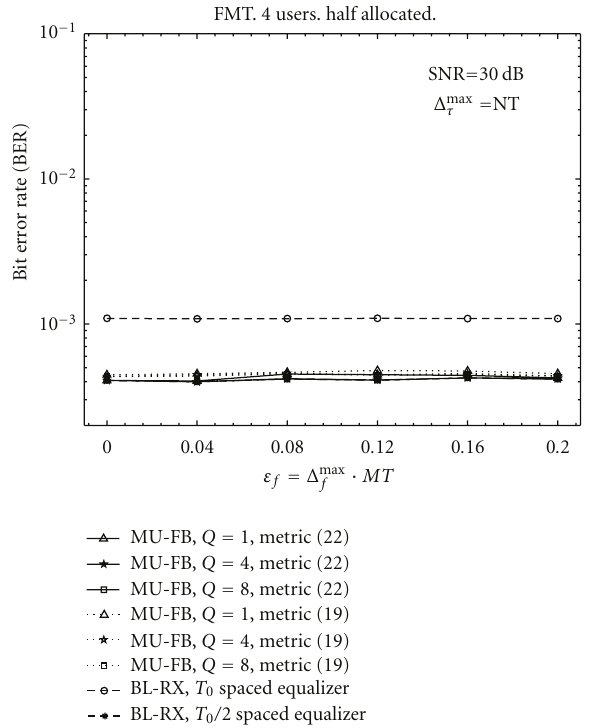
Figure 5: BER as a function of frequency o ff set. 8 interleaved users with only 4 nonadjacent active users. Comparison of the compensation metrics for di ff erent values of Q. FMT with M = 32 and N = 40 .